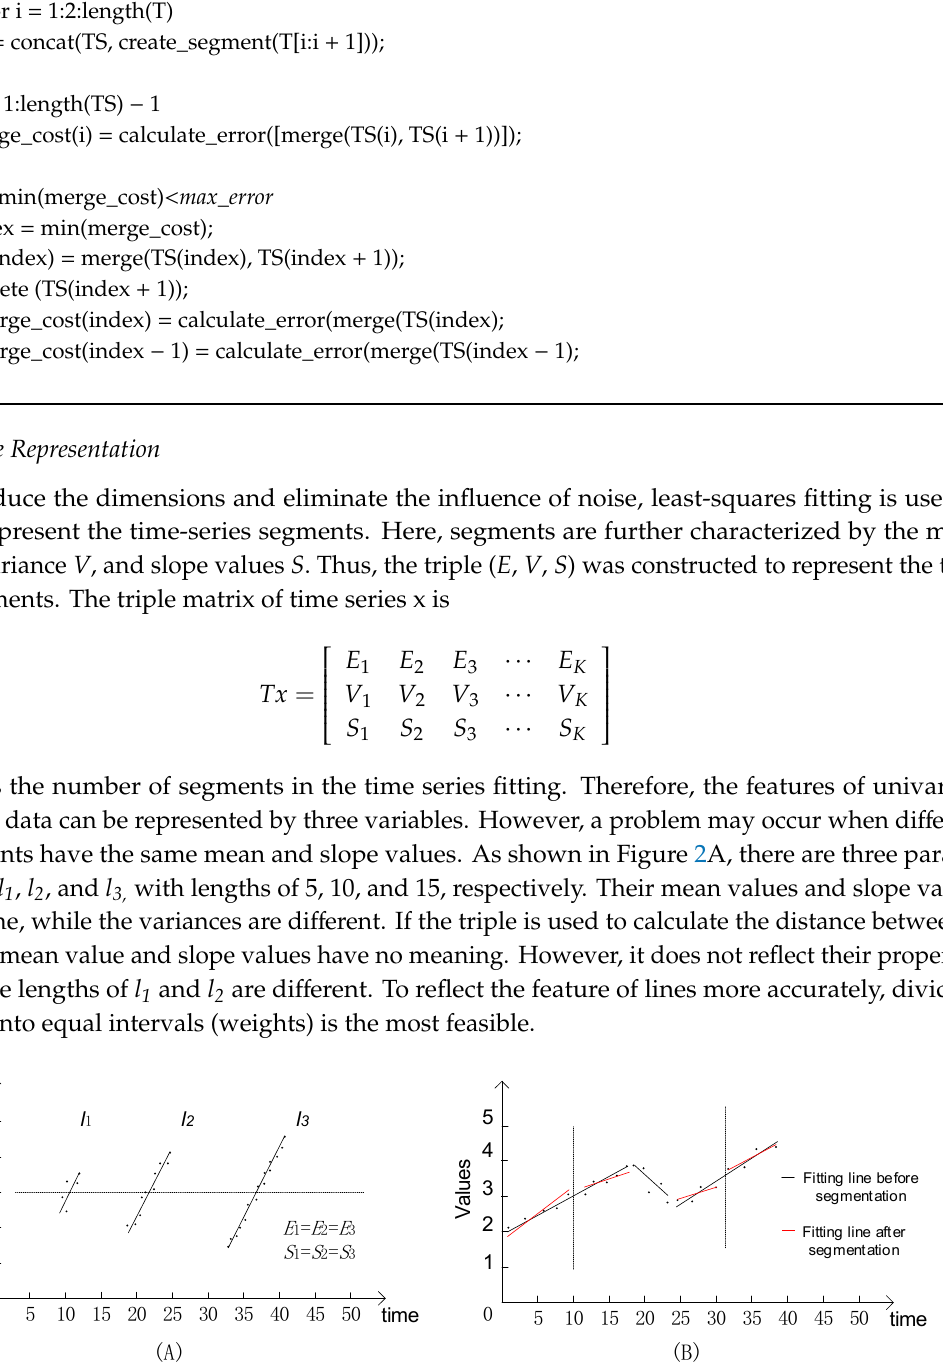
Figure 2. The characteristic analysis and equal interval segmentation of the line. ( A ) The same mean and slope values for l 1 , l 2 , and l 3 ; ( B ) Equal interval segmentation of the line.